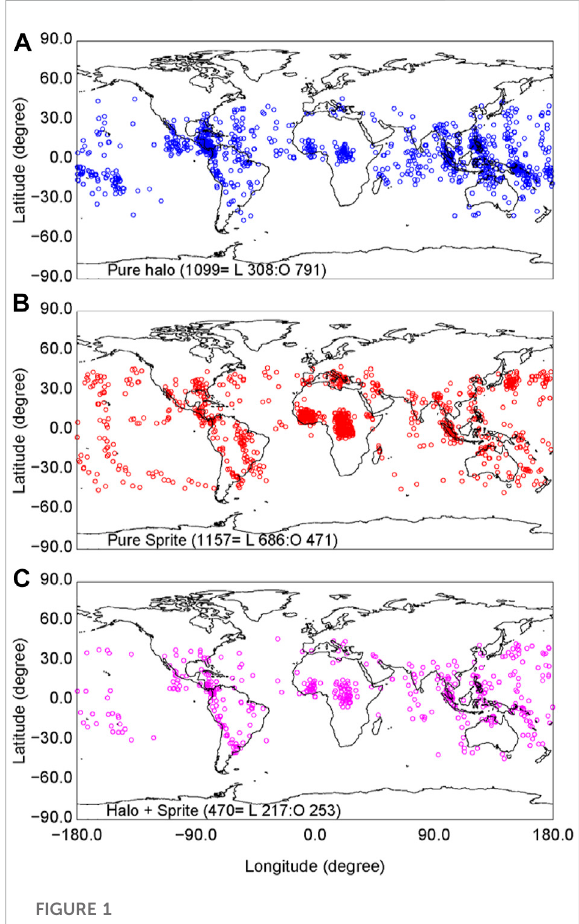
FIGURE 1 Geographicdistributionof (A) purehalos, (B) puresprites,and (C) halo-sprite events observed by ISUAL during 2004 –